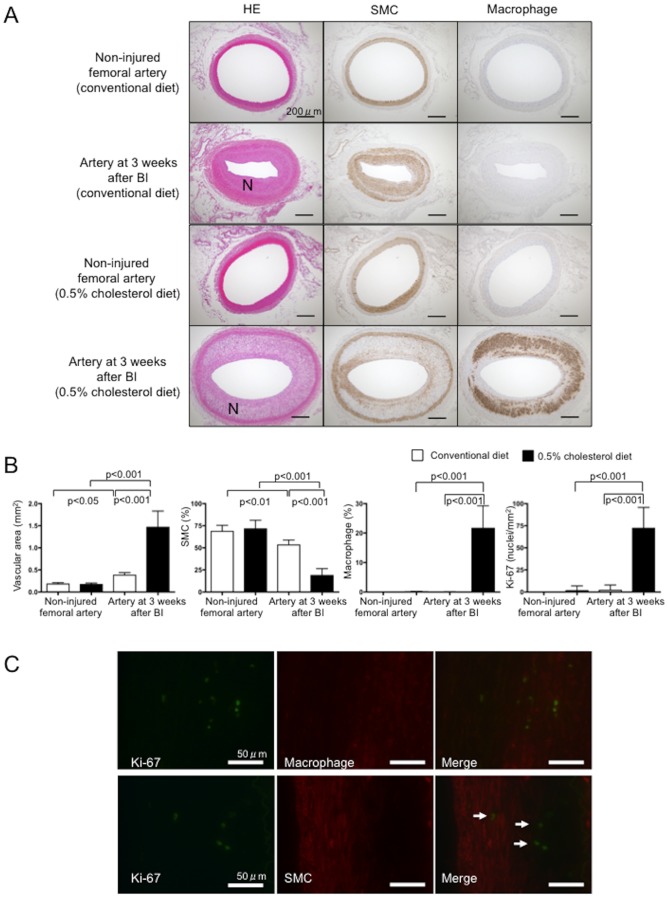
Histological findings of iliac-femoral arteries that were not injured or those at three weeks after balloon injury in rabbits fed with conventional or 0.5% cholesterol diets.A. Representative histological images of arterial sections stained with hematoxylin eosin (HE), and antibodies for muscle actin or rabbit macrophages. N, neointima; BI, balloon injury. B. Vascular areas, as well as areas that are immunopositive for SMCs and macrophages, and numbers of Ki-67-immunopositive nuclei in arteries. White and black bars, conventional and 0.5% cholesterol diet, respectively; n = 12 each). BI, balloon injury. Arteries at three weeks after balloon injury shows neointimal formation rich in SMCs (conventional diet) or macrophages (0.5% cholesterol diet), compared with non-injured arteries. C. Representative double immunofluorescent images for Ki-67 and macrophage or SMC in arteries 3 weeks after balloon injury in rabbits fed with 0.5% cholesterol diet. Images stained with CF488A labeled anti-Ki-67 antibody (green), CF495-labeled anti-macrophage antibody (red) or anti-SMC antibody (red), and merged immunofluorescent images. There are Ki-67 immunopositive nuclei in macrophages (upper row). The cells with Ki-67-immunopositive nuclei don't have SMC-positive cytoplasm (arrows).